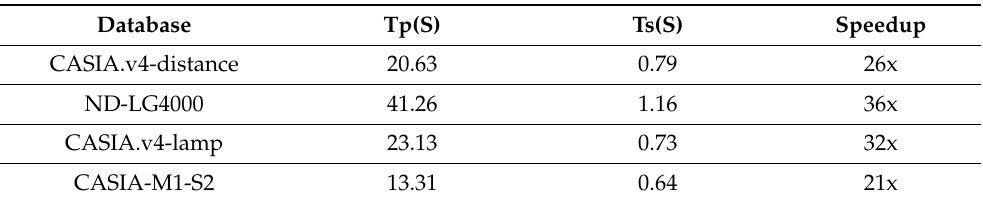
Table 1. Comparison between the average runtime of the serial and parallel algorithms at the iris localization stage on different databases.